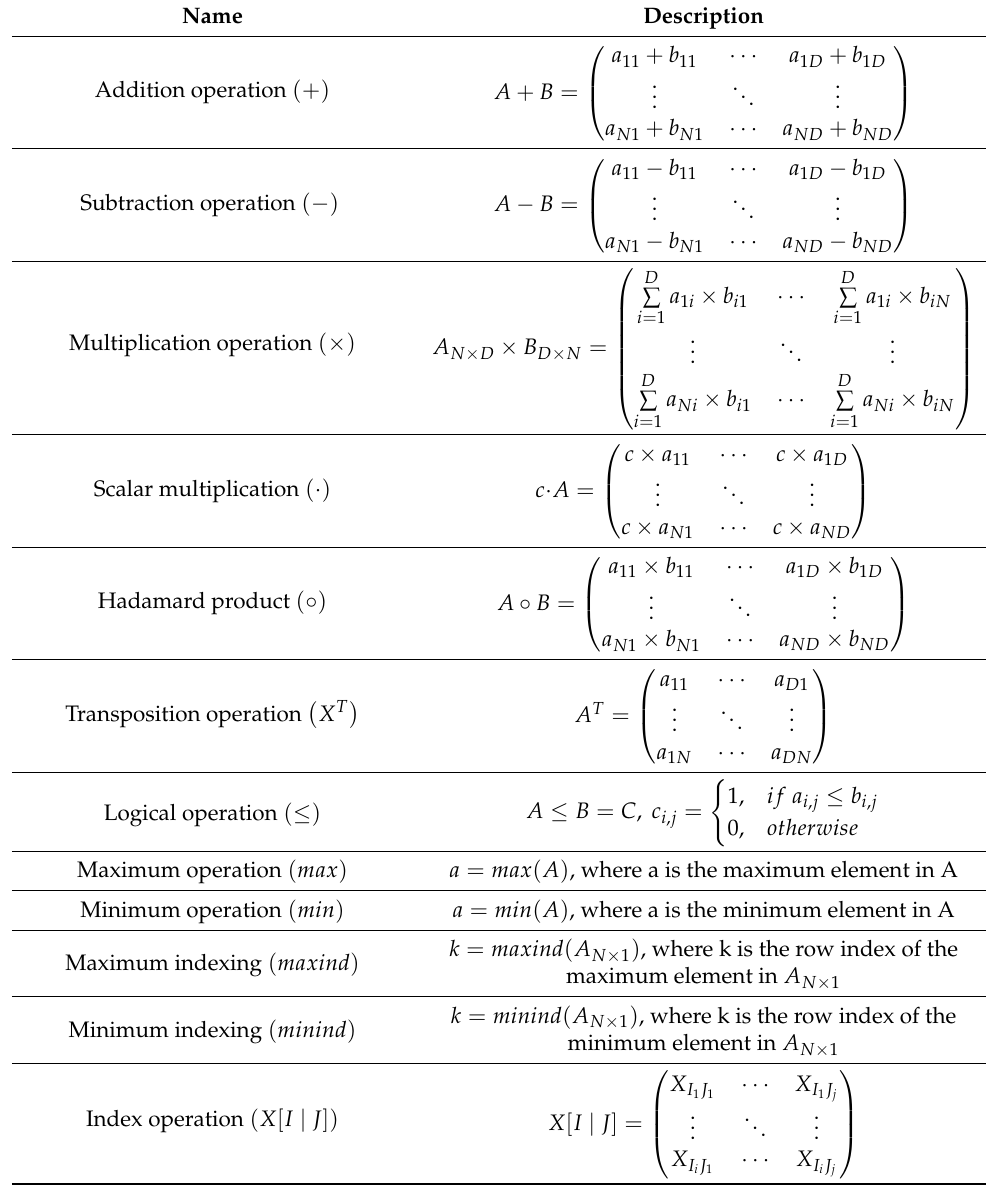
Table 1. Typical operations in matrix and their notations